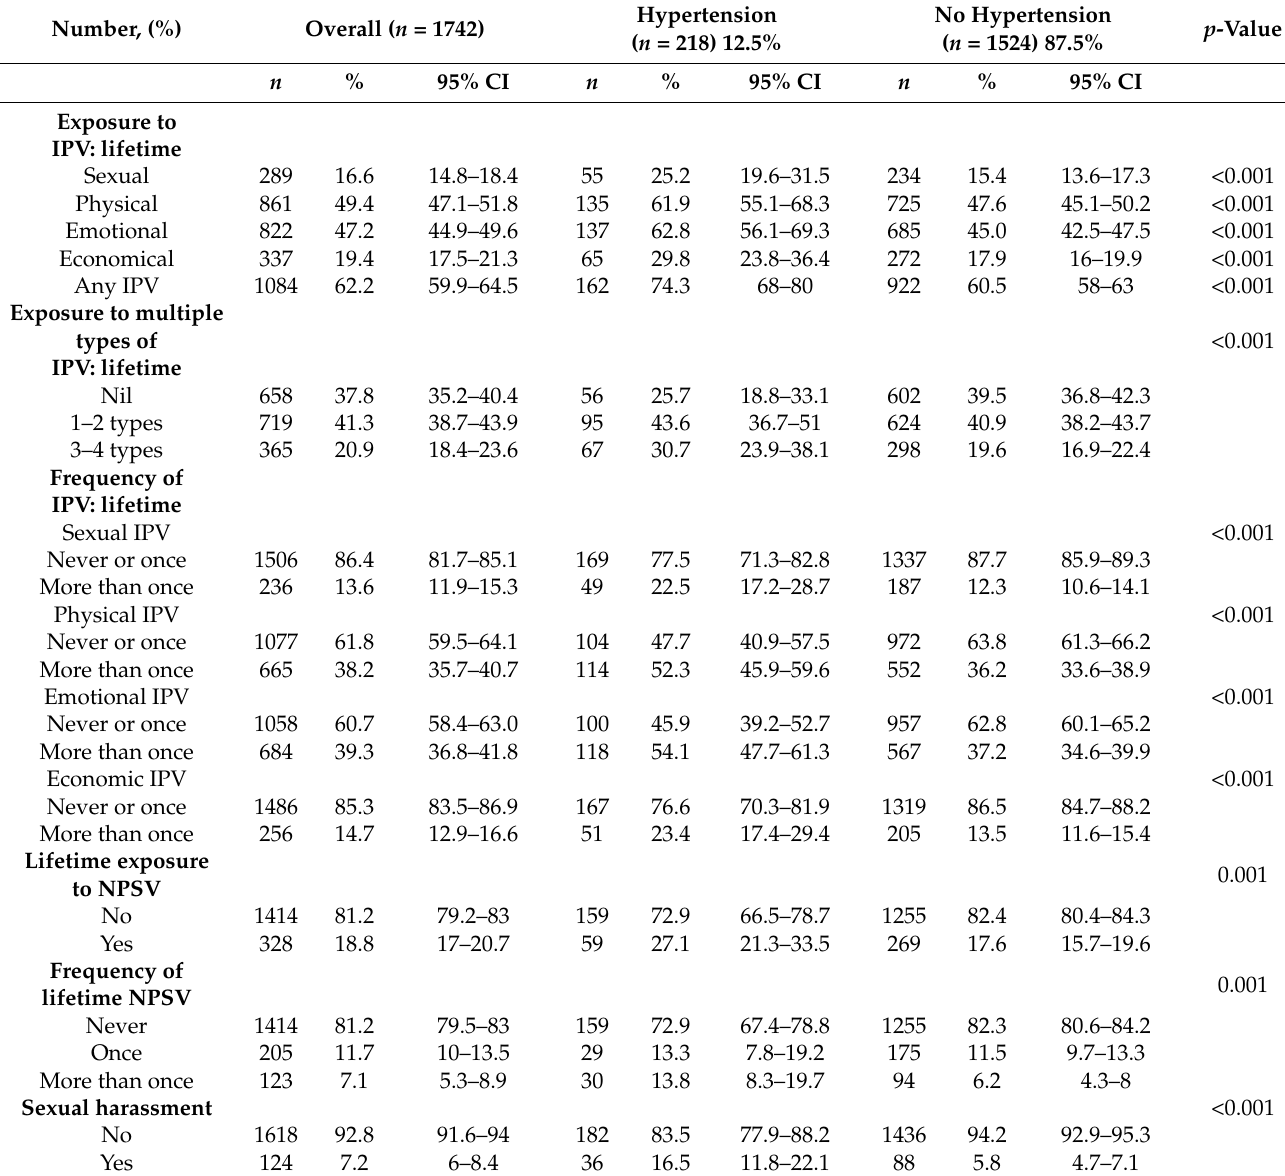
Table 2. Prevalence of lifetime intimate partner violence, overall and by hypertension